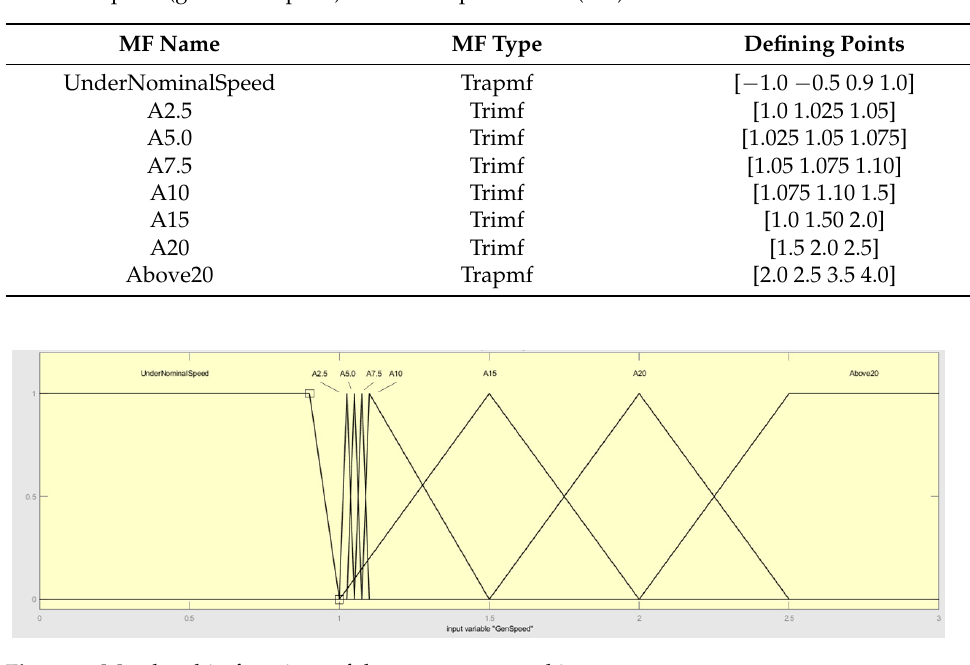
Table 2. Input 1 (generator speed) membership functions (MF).